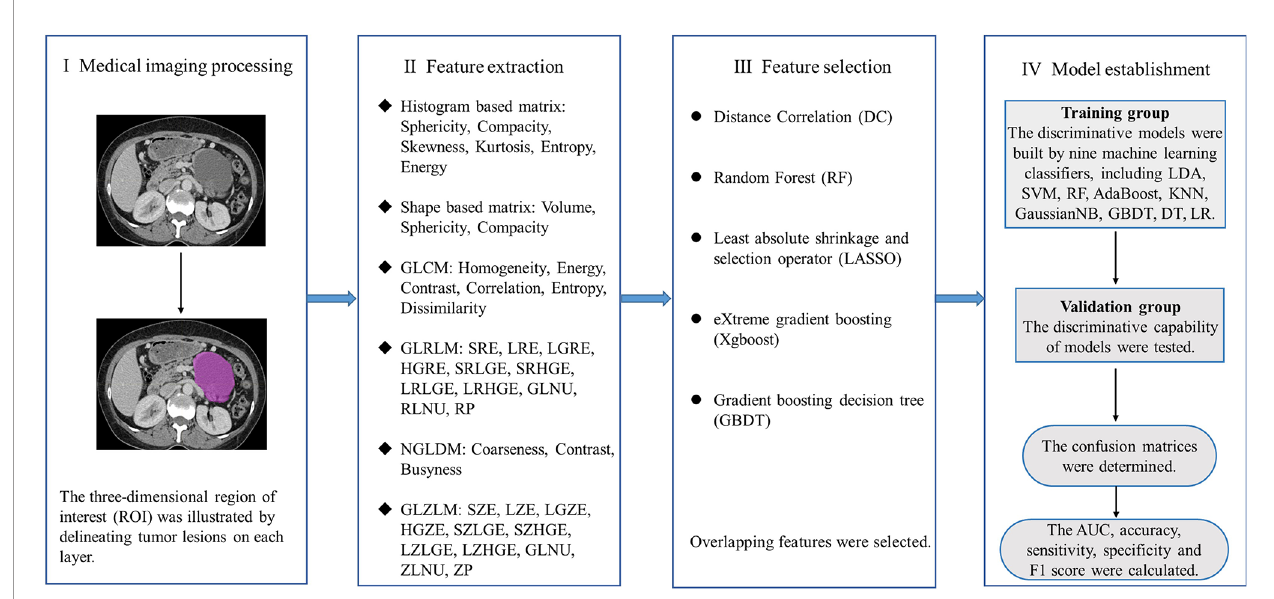
FIGURE 3 | Flowchart depicts the work fl ow of the whole